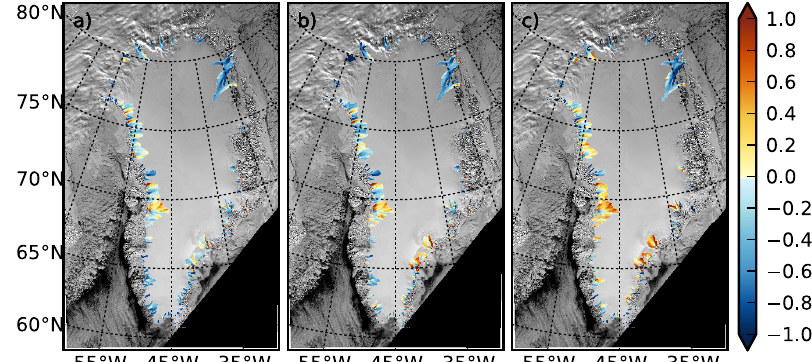
Fig. 3. Relative difference in surface speeds (model-observation)/observation. (a) “constant-climate” hindcast. (b) “paleo-climate” hindcast. (c) “flux-corrected” hindcast. Blue and red colors indicate the model under- and overestimates surface speed, respectively. Areas of observed surface speeds smaller than 100ma − 1 (92% of observed speeds) are masked out because small absolute speed differences result in large relative speed differences. Also uncertainties in SAR-derived surface speeds are higher in slow-flowing